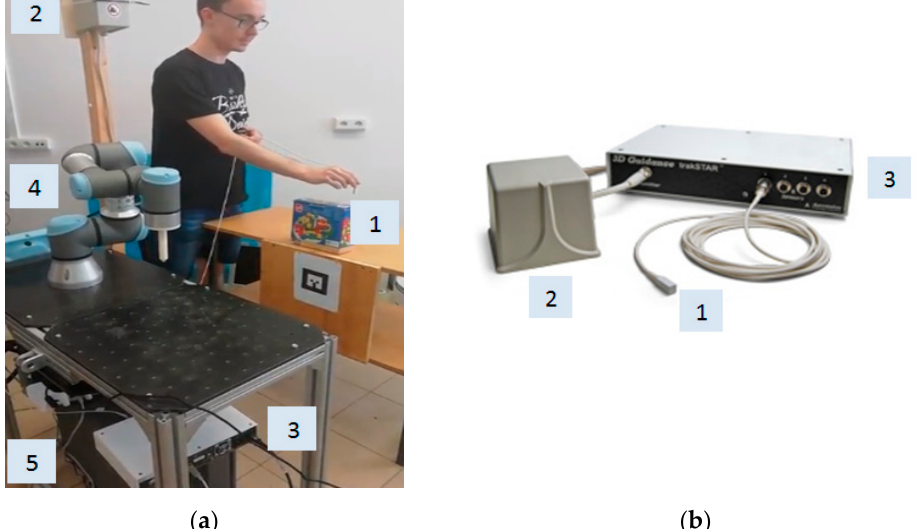
Figure 5. Human robot interactions: ( a ) human operator holds and moves TrakSTAR sensor (1) along the trajectory being generated for UR3 robot (4) to follow; ( b ) TrakSTAR electro-magnetic 6-DoF tracker, where (1) is the TrakSTAR sensor, (2) the Mid-Range Transmitter, (3) TrakSTAR Electronics Unit, (4) UR3 manipulator, (5) UR3 control box.